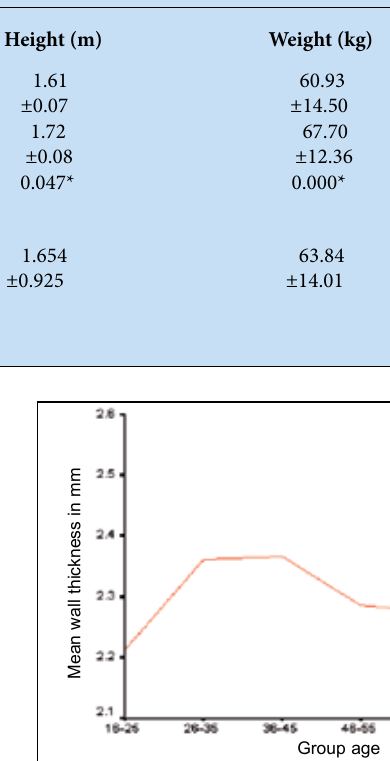
Table III. Comparison of the mean gallbladder wall thickness and body parameters in the different sexes